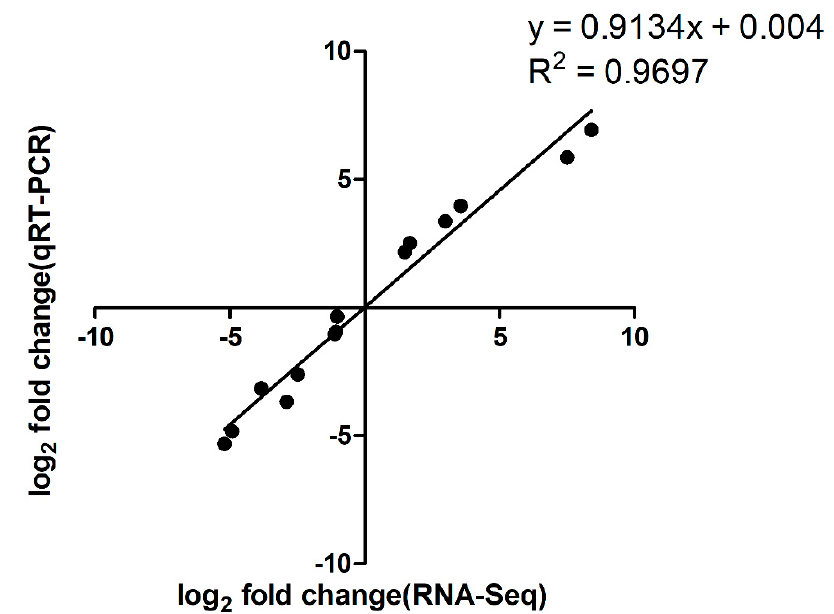
Figure 3. Correlation between RNA sequencing data and qRT-PCR results. A subset of seven genes with varying fold changes was selected to confirm the accuracy of RNA sequencing results by qRT-PCR analysis. The fold changes obtained by these two methods were log 2 transformed, and the values were plotted against each other to assess their correlations. The fold changes of these genes are shown in Table S5.